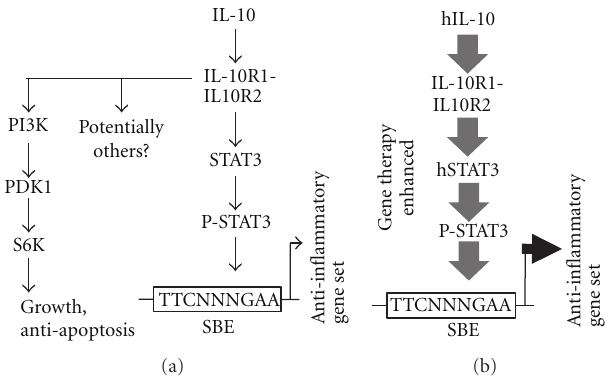
Figure 1: IL-10 signal transduction and hypothesized treatment by dual gene therapy. (a) shows multiple possible IL-10 signal transduction pathways. The STAT3 pathway results in an anti-inflammatory response. (b) shows our attempt to enhance IL-10 signaling at two points with the hypothesis that enhanced gene expression of the anti-inflammatory gene set would occur. The gene delivery is indicated by larger font and bolded IL-10 and STAT3. More powerful signal transduction is represented by larger arrows and larger font.